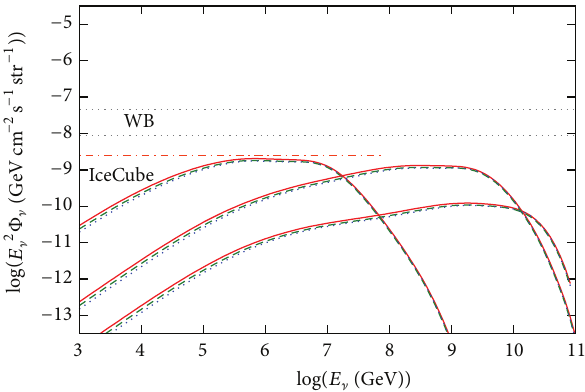
Figure 4: Afterglow neutrino fluxes shown by Murase